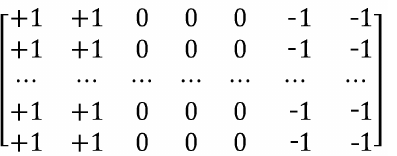
Figure 6. Large receptive field gradient